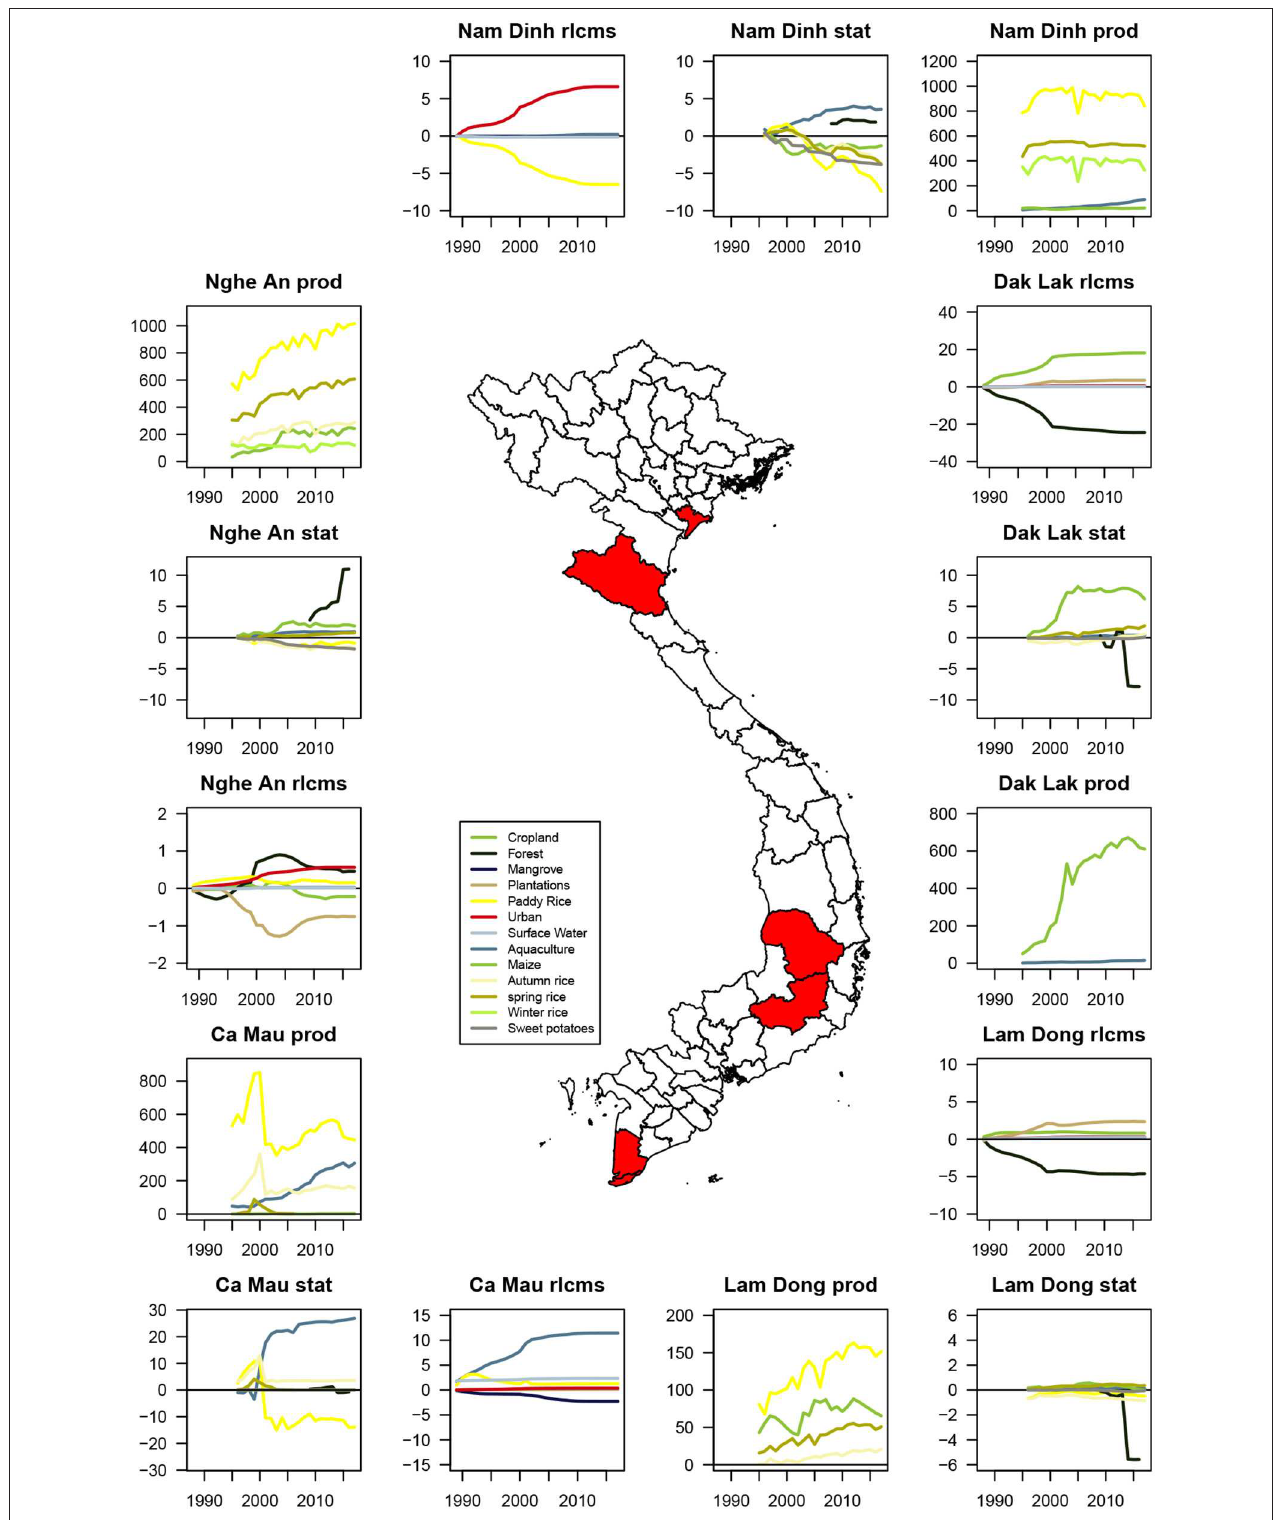
FIGURE 6 | The change in area from RLCMS, the statistical yearbook (stat) and the total production (prod) for different crop types. Change in area from RLCMS and the statistical yearbook are expressed as a percentage (%), the unit of production is in thousand tons.